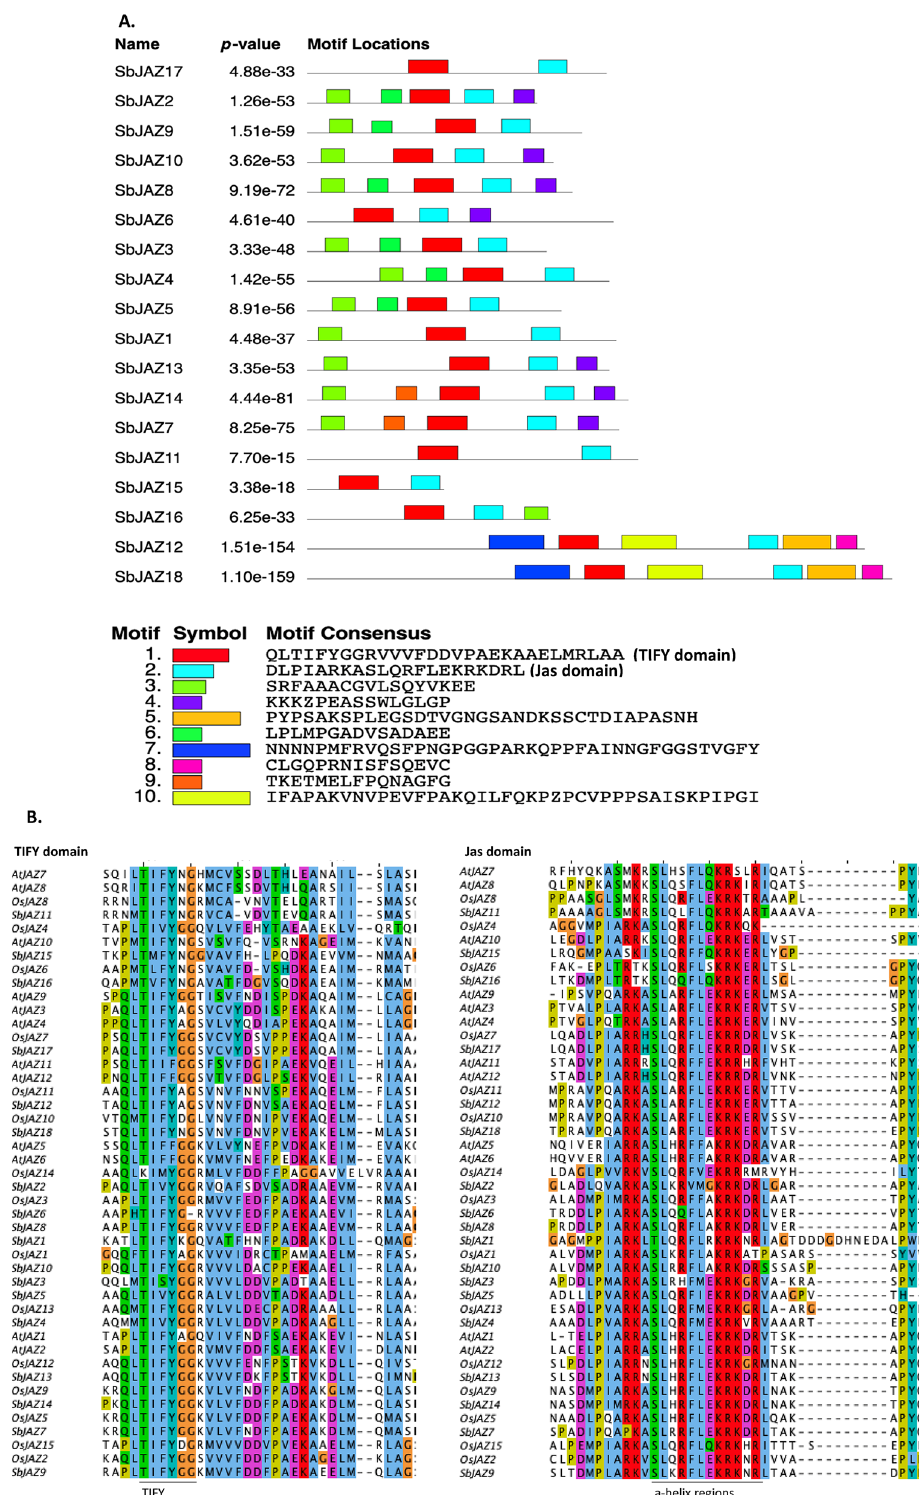
Figure 5. ( A ) Schematic representation of the conserved motifs in sorghum JAZ proteins. Conserved motifs and their alignment among JAZ proteins was elucidated by using MEME tool. Most of the proteins possess similar domains revealing their conserveness. Each colored box represents a motif in the protein, with the consensus motif sequence below in the index. ( B ) Cross-species comparison of TIFY and Jas domains revealed the sequence conservation of these